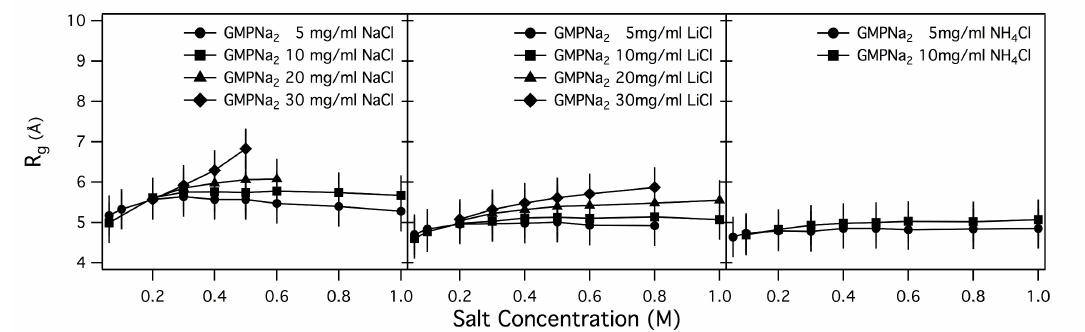
Figure 6. Ionic strength dependence of R g measured from GMPNa 2 samples prepared in NaCl, LiCl and NH 4 Cl. GMPNa 2 concentrations are reported in each frame.